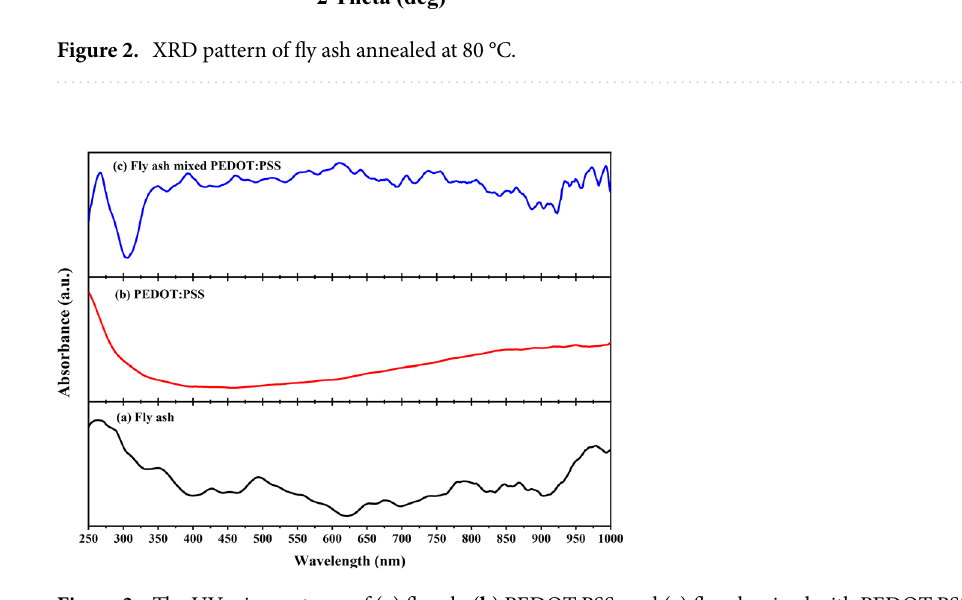
Figure 3. The UV–vis spectrum of ( a ) fly ash, ( b ) PEDOT:PSS, and ( c ) fly ash mixed with